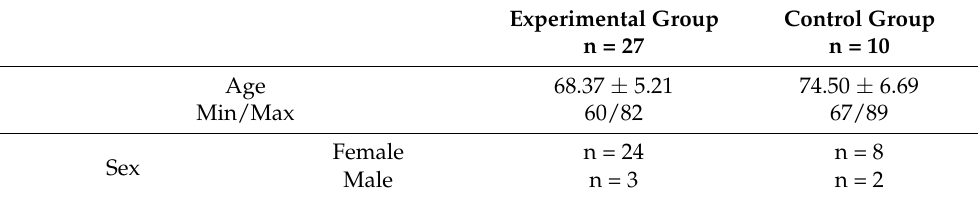
Min—minimum; Max—maximum; Results expressed as mean ± standard